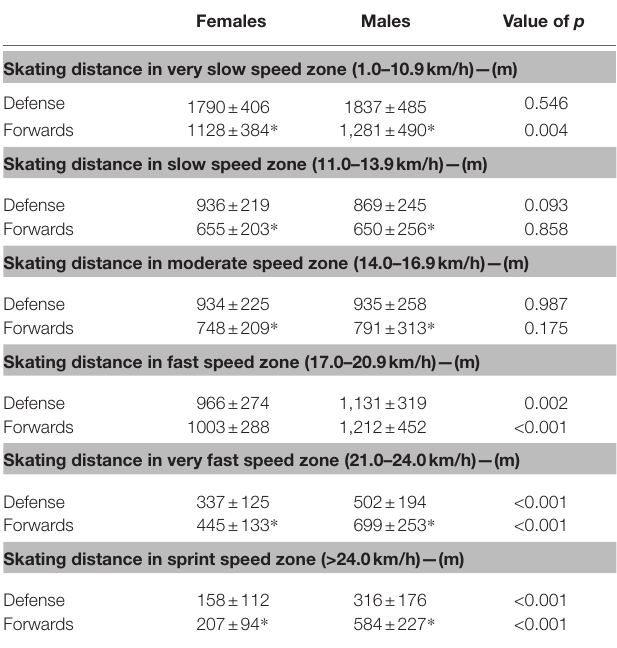
TABLE 2 | Comparison of local positioning system measured absolute skating distances between females and males during regular season ice hockey games. Females Males Value of p